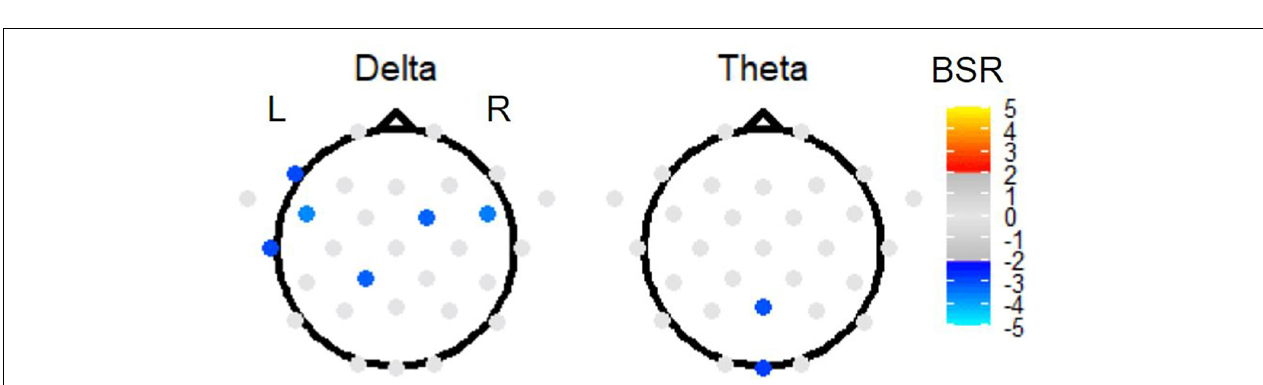
FIGURE 6 | The BSRs of the first latent variable in the Link (A + B) vs. Non-link (A + B) task PLS subtest. All electrode BSRs were FDR-corrected and thresholded as described in the text.